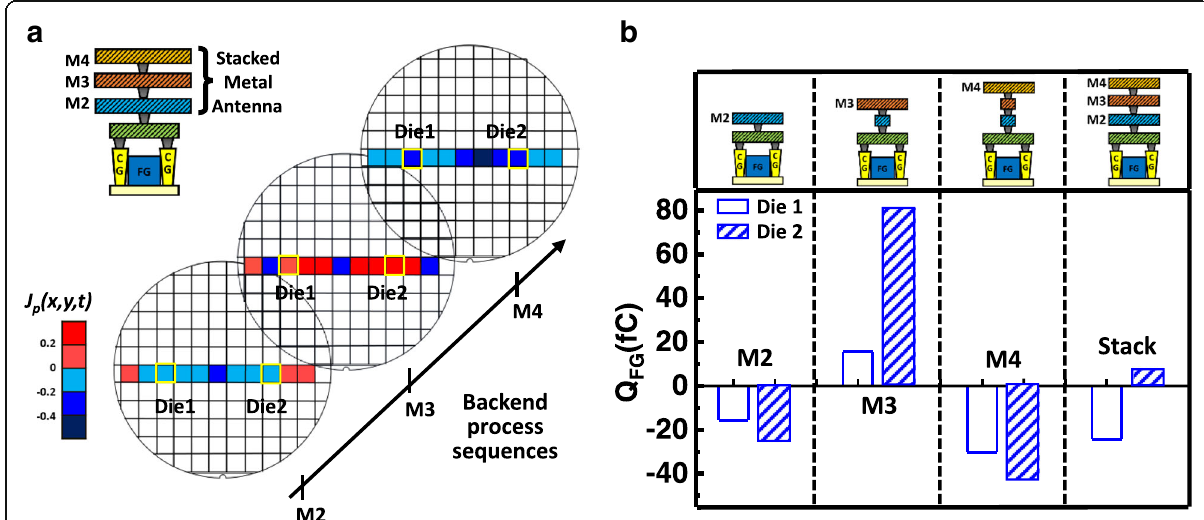
Fig. 3 a The plasma charging effect for the different metal layers varies on different locations across the wafer. b The positive and negative charges may compensate each other in the stacked metal